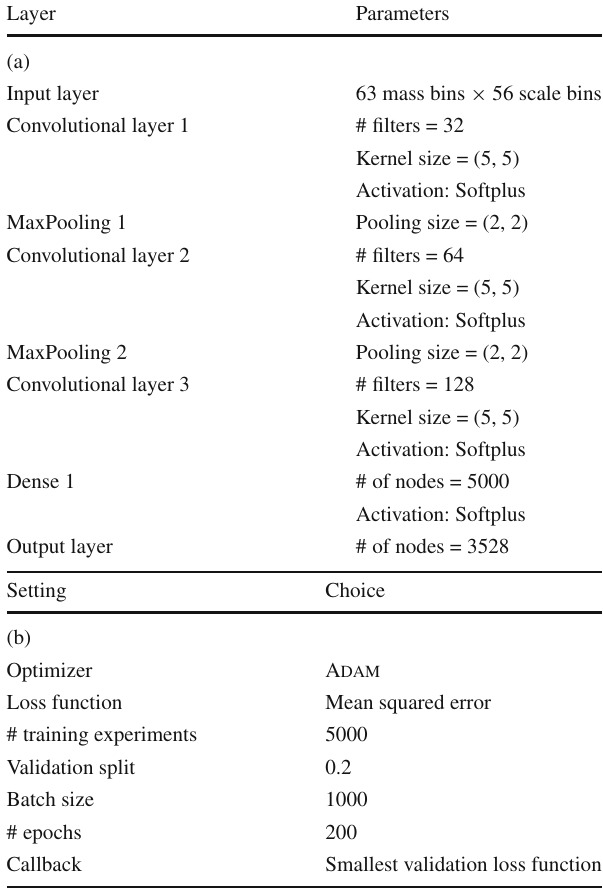
Table1 (a)Structureoftheconvolutionalneuralnetworkfortheregion finder. (b) Training parameters. All parameters not specified in these tables are left at their default Keras